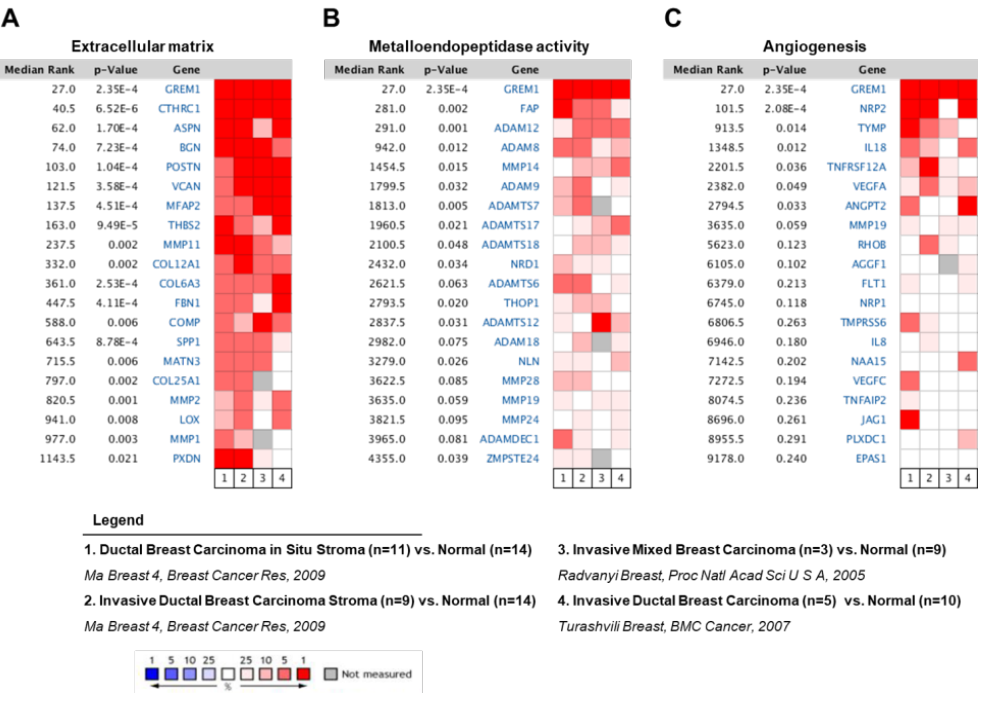
Figure 1. The GREM1 gene is highly expressed in breast cancer patients. Oncomine microarray database was used to analyze GREM1 mRNA expression in breast cancer versus normal breast tissues. The level of GREM1 expression was compared with the levels of multiple genes corresponding to ( A ) extracellular matrix, ( B ) metalloendopeptidase activity, and ( C ) angiogenesis. Four datasets were included in the meta-analysis. Red represents overexpression and blue represents low expression.